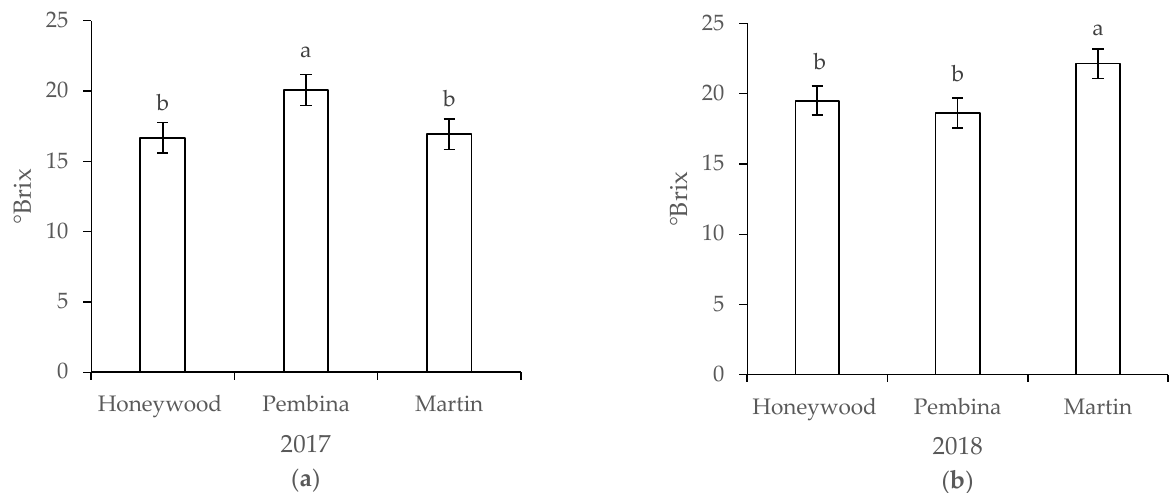
Figure 5. Soluble solid content (SSC) of the studied cultivars in ( a ) 2017 and ( b ) 2018. Values with different letters are significantly different within a year.